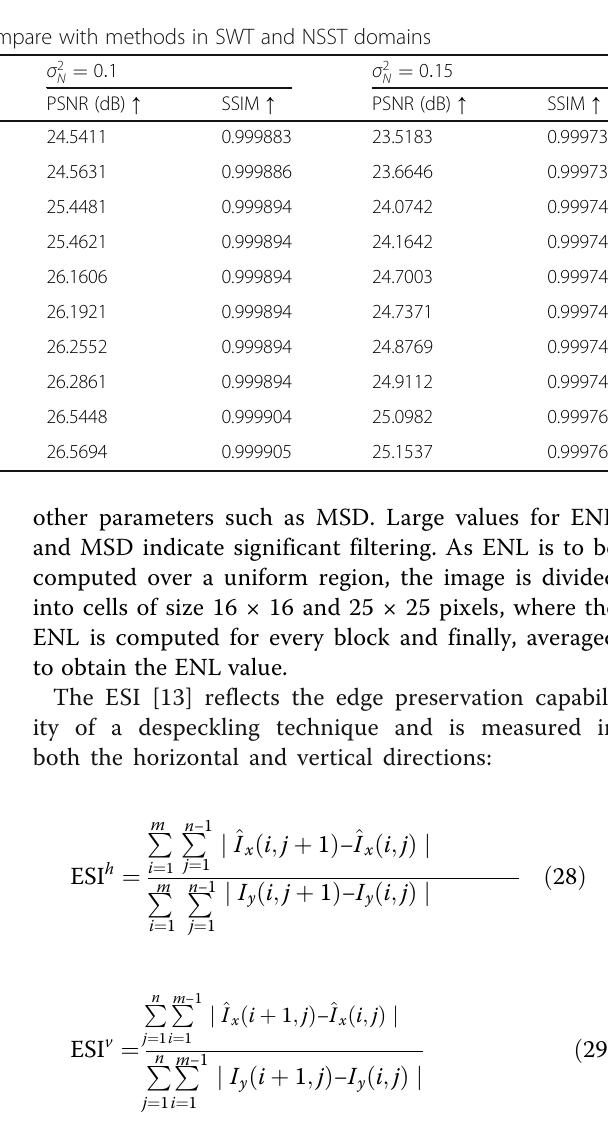
σ 2 0 : 05 σ 2 N ¼